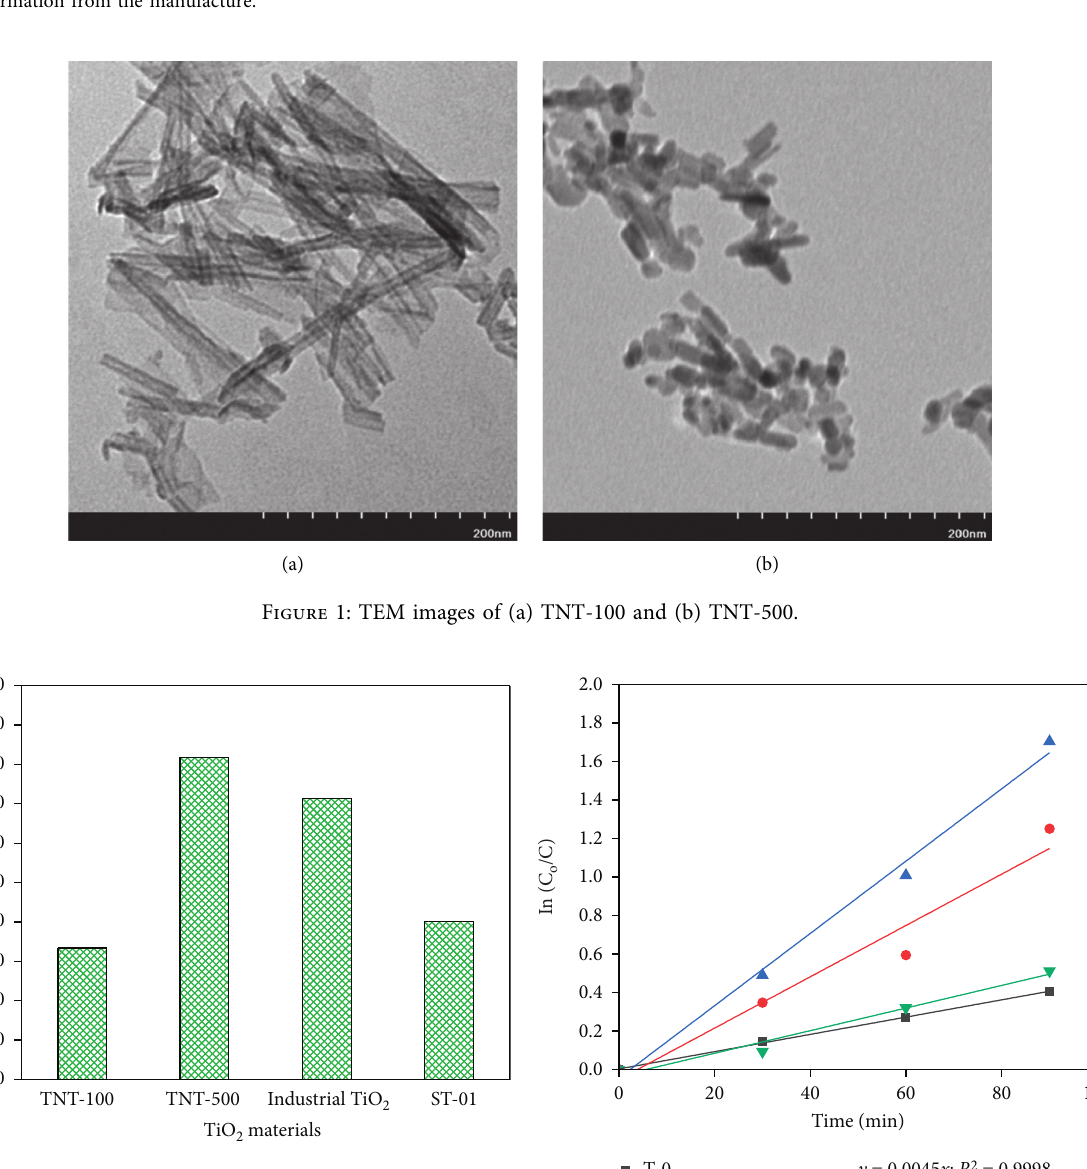
2 materials (0.1 g of catalyst, pH 6.3, 1